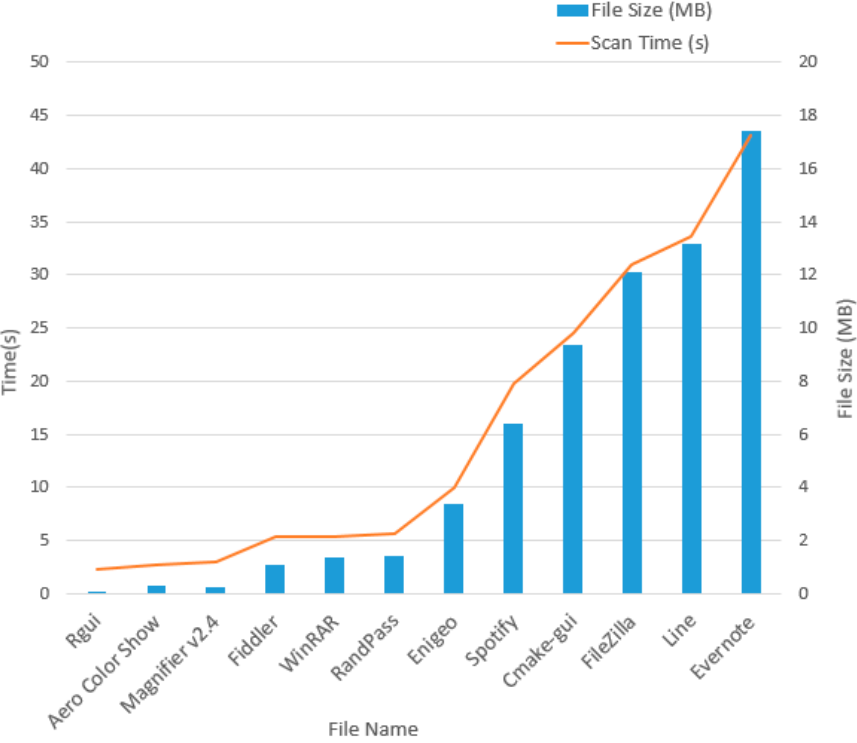
Figure 4. Average scanning time of various executables with different file sizes.